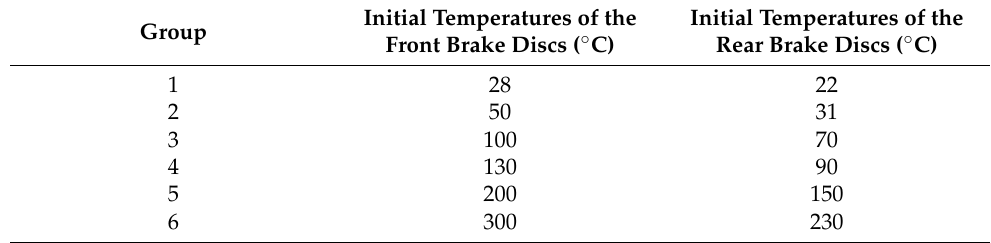
Table 4. Initial temperatures of the brake